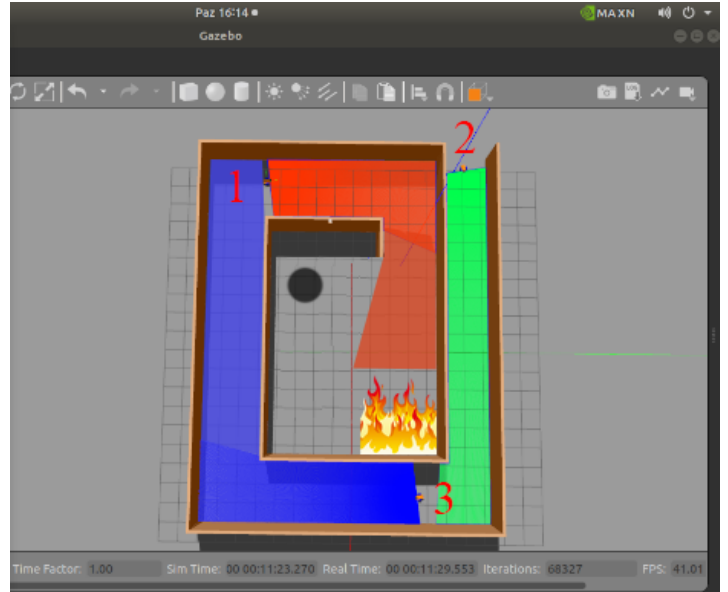
Figure 9. Environment and Motion Images for Simulation 2.